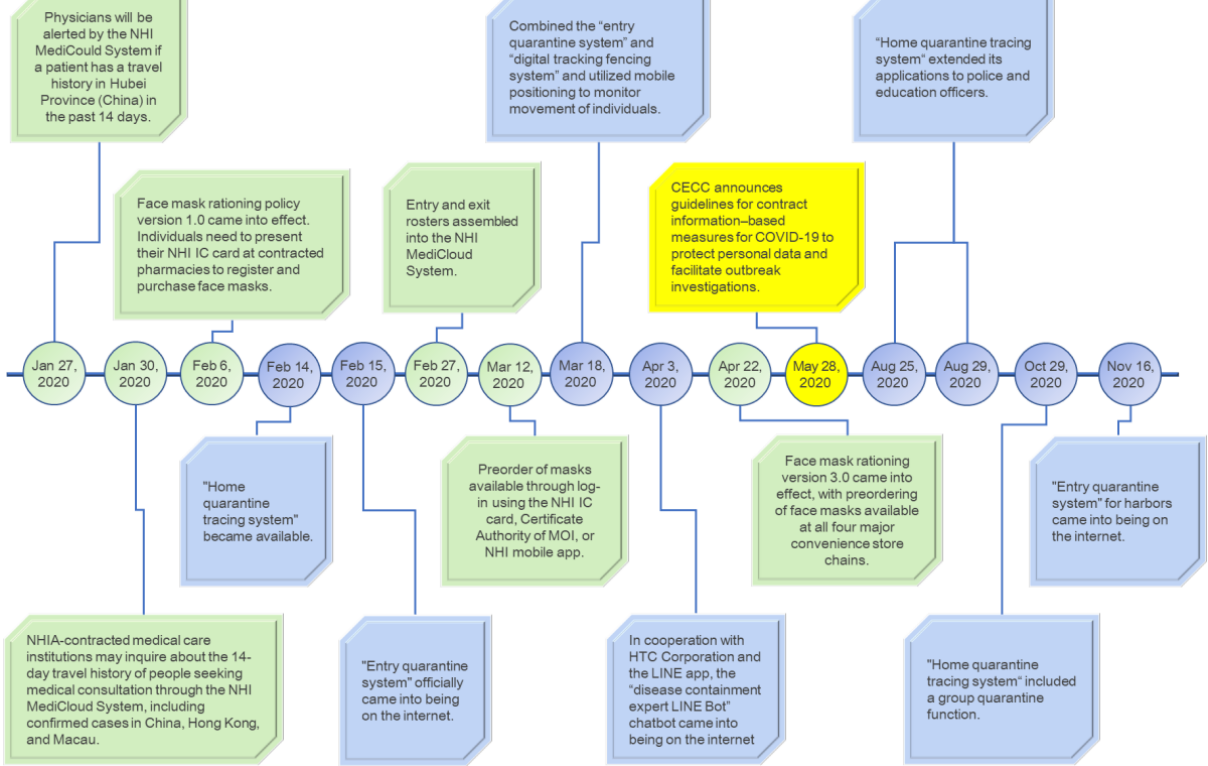
Figure 2. Timeline of technology usage in COVID-19 prevention in Taiwan. Green blocks represent the launching date of the travel history inquiry system and the name-based mask-rationing system, blue blocks represent the procedures and services for border control and the home quarantine system, and the yellow block represents the date when CECC announced guidelines for contact information–based measures and data collection. CECC: